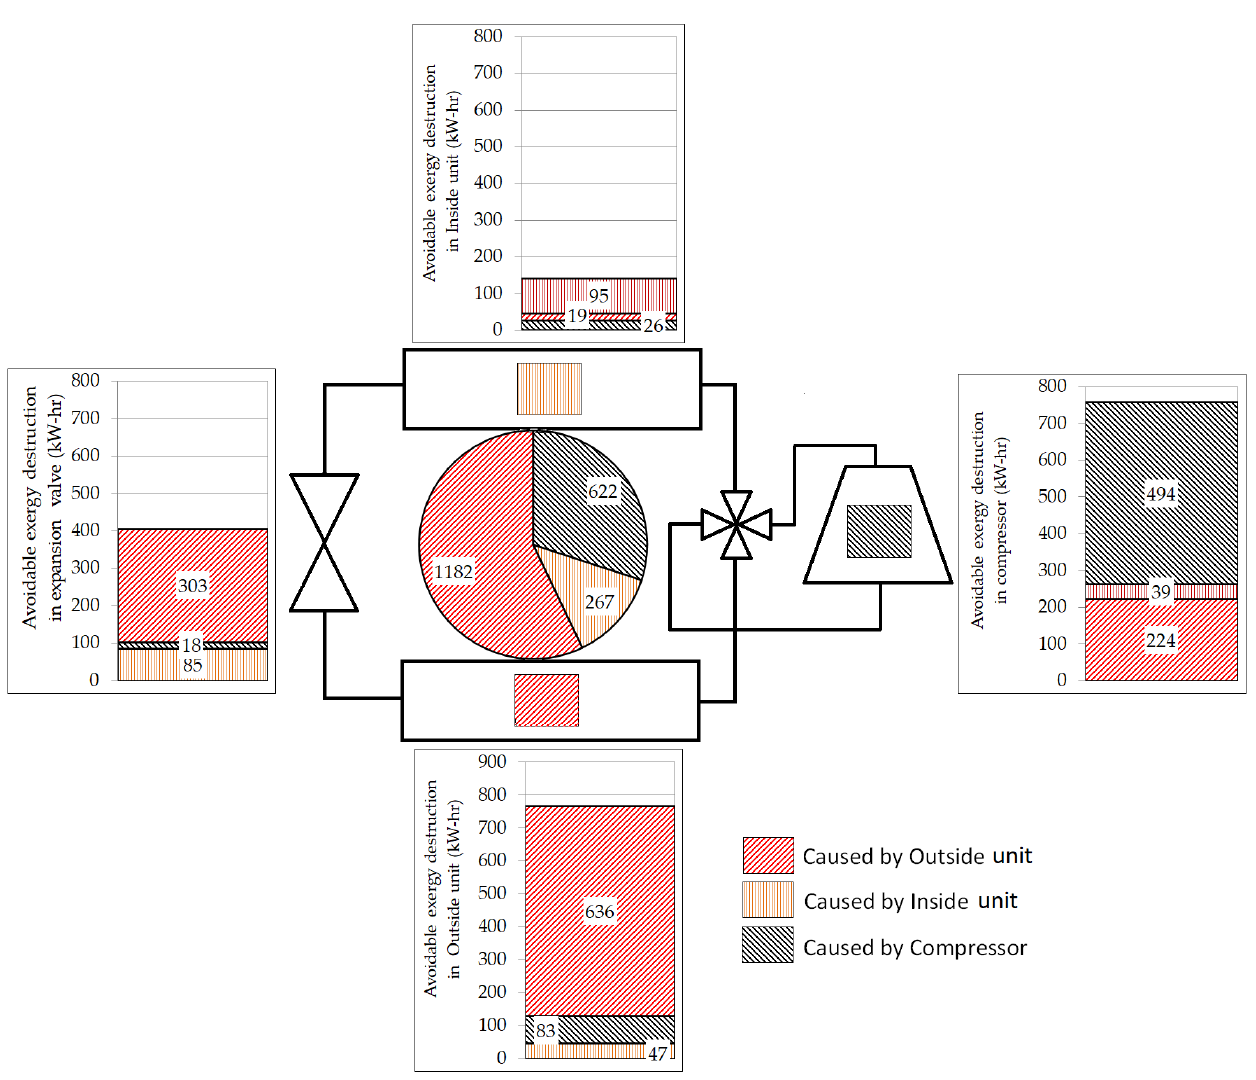
Figure 6. Annual values of the internally caused and externally caused avoidable exergy destruction ∑ , INT , EXT , yr AV, ,INT,EXT,yr E  (kWh) in the components of the investigated reversible heat pump operating with tion E AV , (kWh) in the components of the investigated reversible heat pump operating D,k D , k with R290.